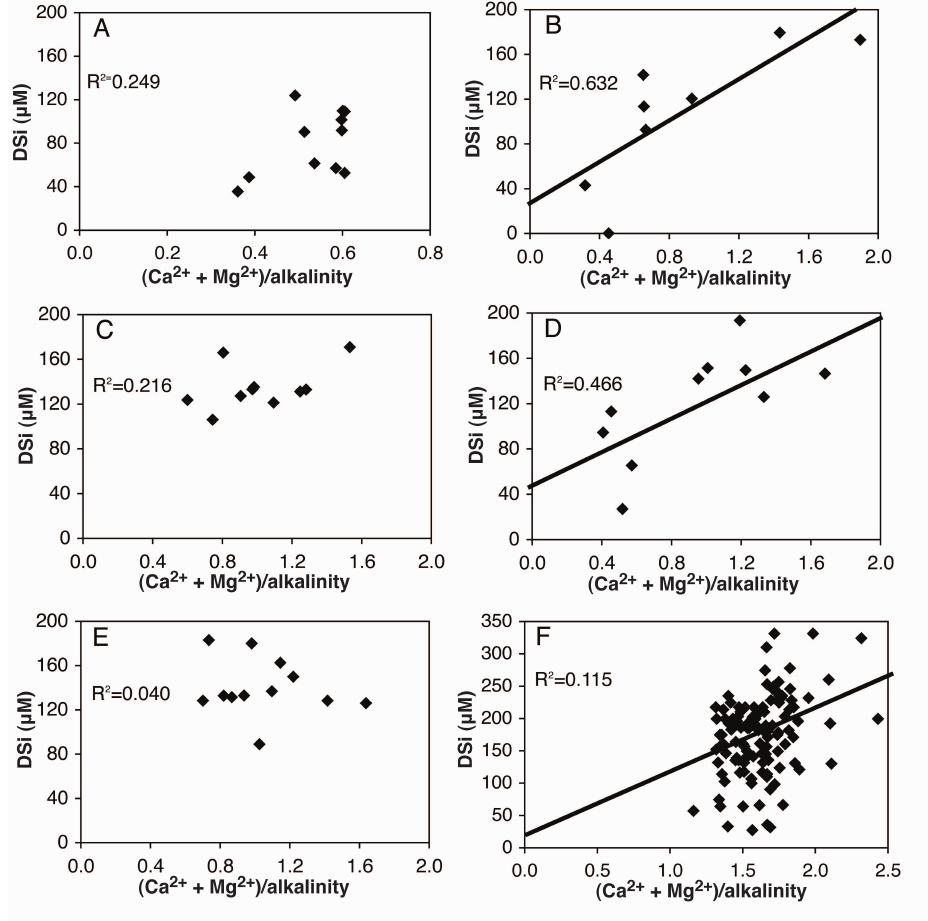
Fig. 7. (Ca 2 + + Mg 2 + ) /alkalinity molar ratios vs. DSi concentrations for NAEW watersheds: (A) 115 Corn No-Till, (B) 127 Corn Till, (C) 166 Mixed-Use, (D) 172 Forest, (E) 182 Unimproved Pasture, and (F) the Ohio-Tennessee River Basin. Significant ( α = 0.05) linear correlations are shown with a black